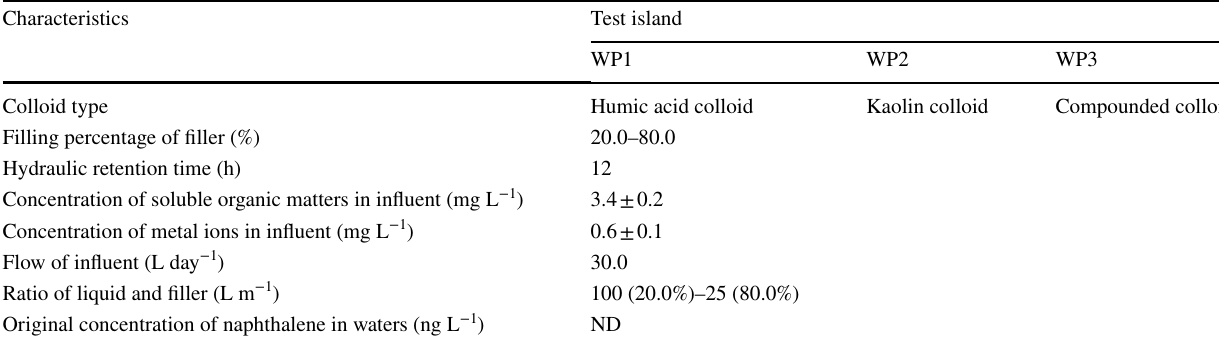
Table 3 Characteristics of the floating islands on removals of naphthalene